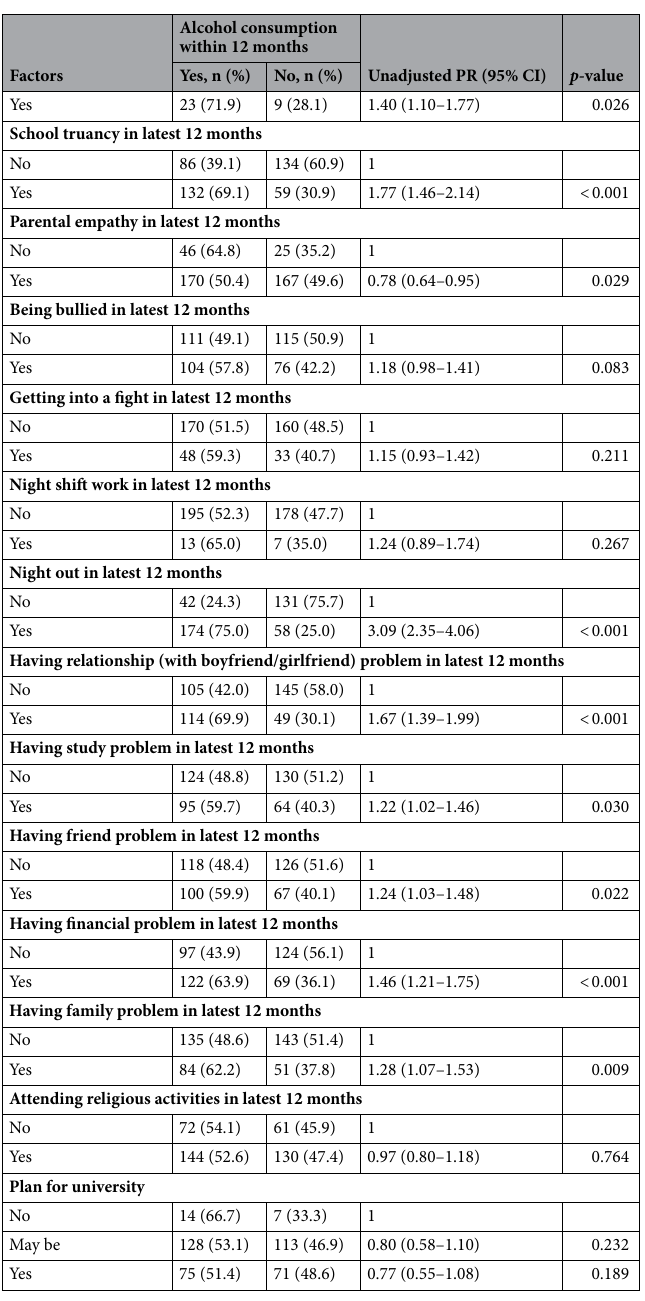
Table 3. Univariable analysis for factors associated with last 12-month alcohol consumption among adolescents in a rural community, central, Thailand. PR prevalence ratio, 95% CI 95% confidence interval, SD standard